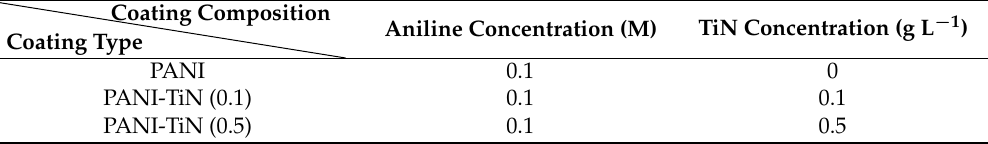
Table 1. Details of different coatings prepared using various electrolyte composition in 0.1 M H 2 SO 4 .